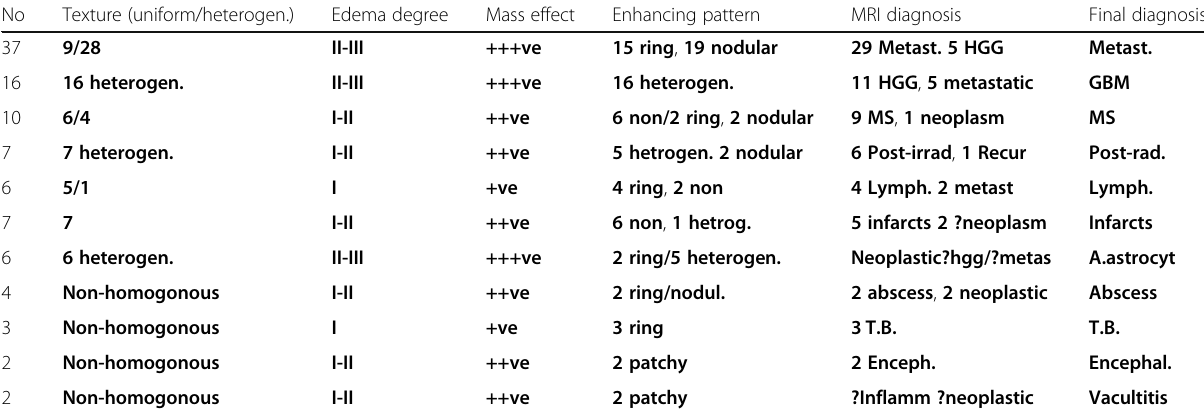
Table 2 Conventional MRI findings of the all studied lesions No Texture